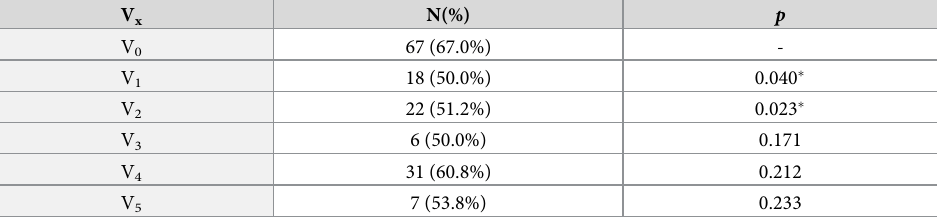
Table 3. Number and percentage of AE patients with detectable Em2+ antibodies at different visits and signifi- cance level in binominal test. Vx = follow-up visit with V0 = baseline, N(%) = total number (percentage of patients) with detectable Em2+, p -value = significance level with � considered